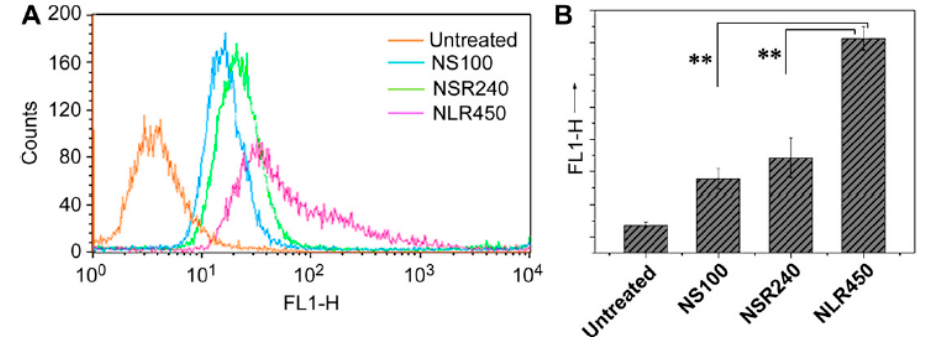
Figure 2. Quantification of the internalization of mesoporous silica NPs: fluorescence intensity ( A ), particle numbers ( B ), using fluorescent-activated cell sorting (FACS). ** Indicates statistical significance, p < 0.01). Reprinted with permission from [70]. Copyright 2010 Elsevier.